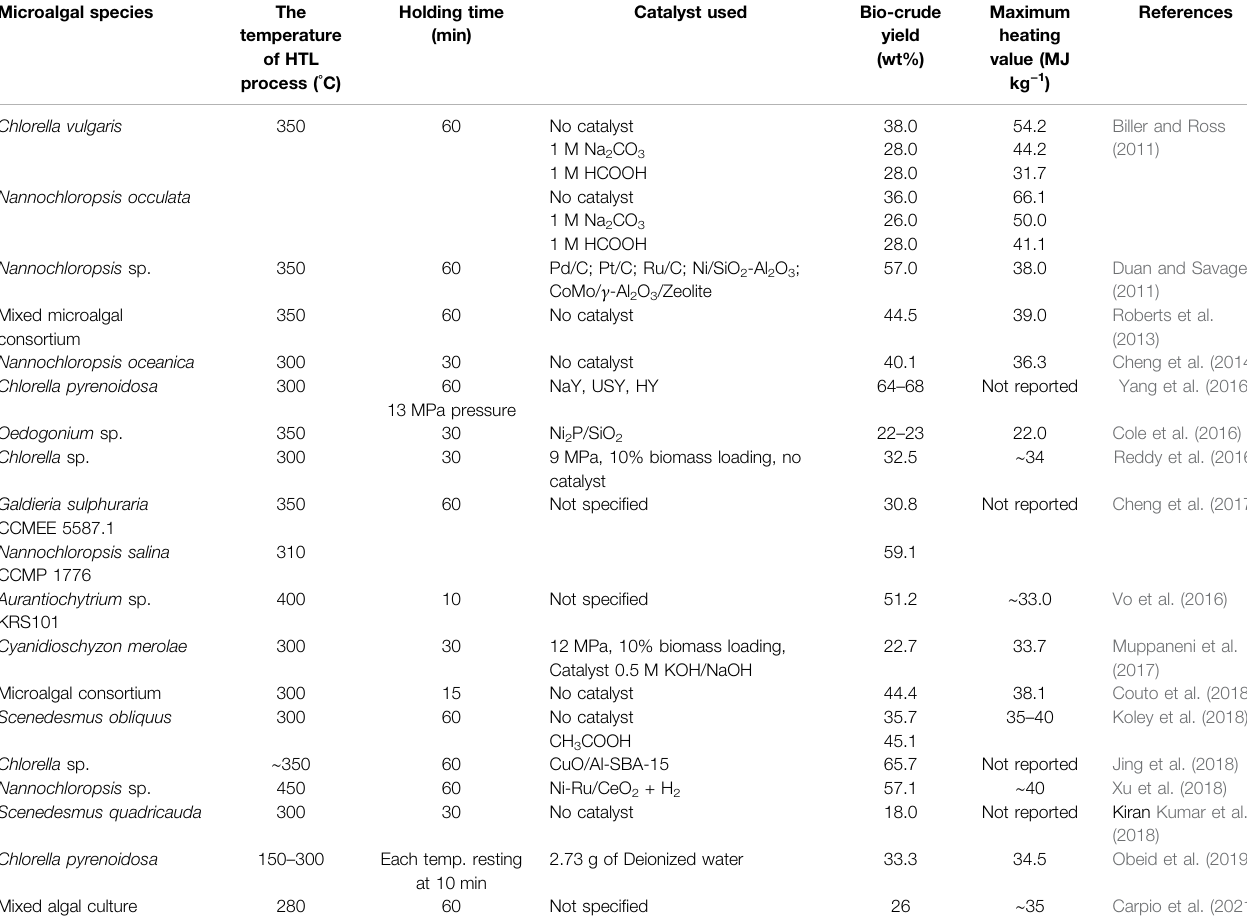
TABLE 3 | Reviews of various recent experimental reports on catalytic/non-catalytic hydrothermal liquefaction process for bio-crude oil